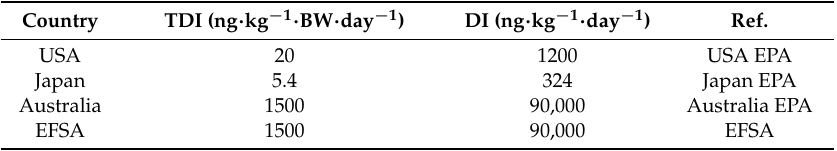
Table 2. The TDI and DI (dietary intake) of PFOA from different countries.